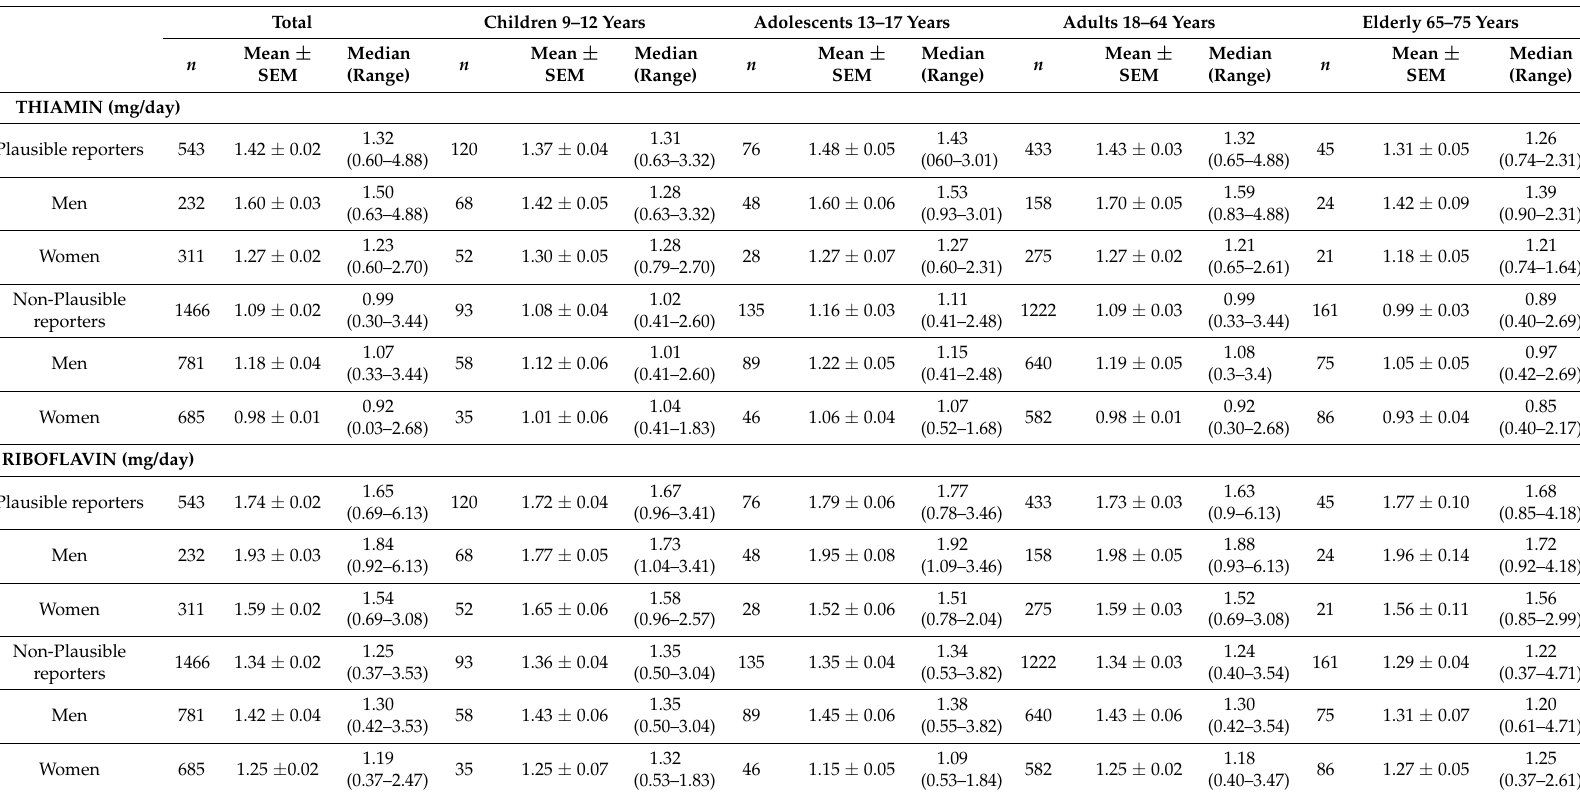
Table 3. Daily thiamin, riboflavin, niacin, and vitamin B 6 reported intake by plausible reporters, non-plausible reporters, and age group in the ANIBES Study